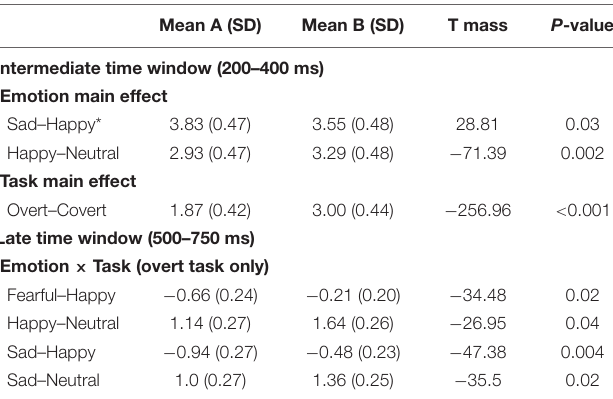
TABLE 3 | Post hoc pairwise mass-univariate tests showing the significant negative and positive clusters in the intermediate time window (200–400 ms) and late time window (500–750 ms).